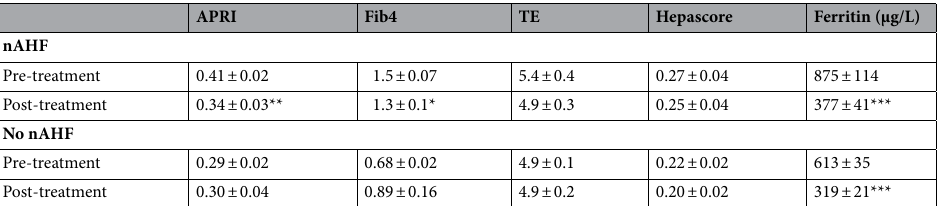
Table 4. Comparison of noninvasive biomarkers pre- and post-treatment in the subjects with either noninvasive biomarker-detected advanced hepatic fibrosis (nAHF) using Fib4 > 1.1 or no evidence of noninvasive biomarker-detected advanced hepatic fibrosis (no nAHF) using Fib4 ≤ 1.1 in Model 1. Results are shown as mean ± SE. APRI: aspartate aminotransferase to platelet ratio index; Fib4: fibrosis-4; nAHF: noninvasive biomarker advanced hepatic fibrosis; No nAHF: no noninvasive biomarker advanced hepatic fibrosis; TE: transient elastography. *P < 0.05, **P < 0.01, ***P < 0.0001 compared with pre-treatment (paired t test).